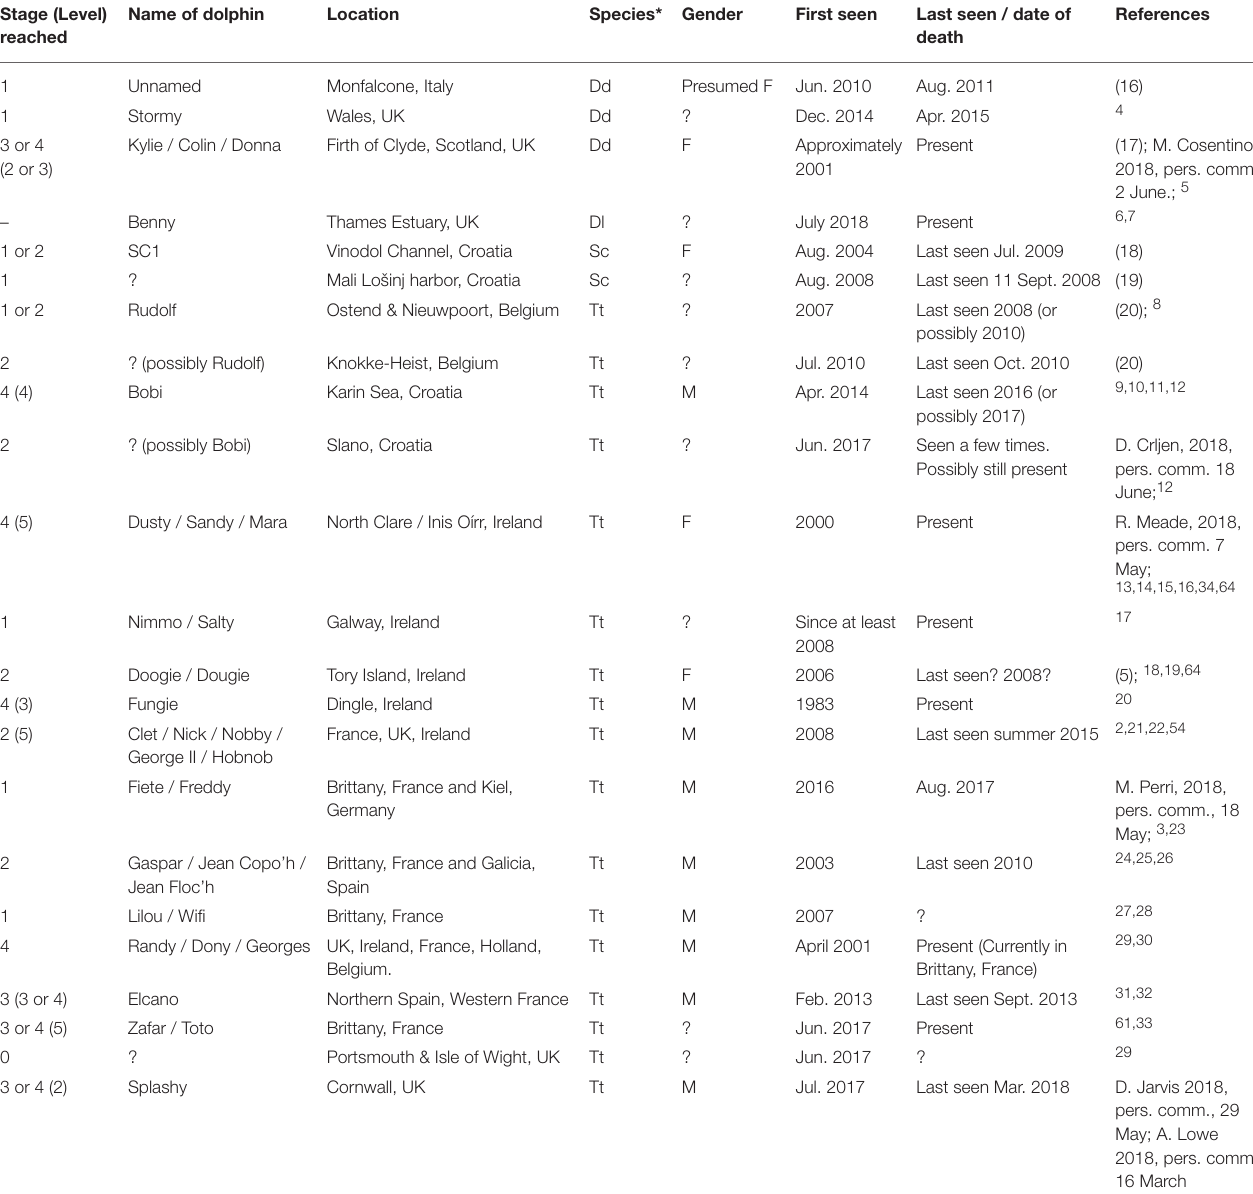
TABLE 2 | Solitary and solitary-sociable dolphins in Europe since 2008. Stage (Level)